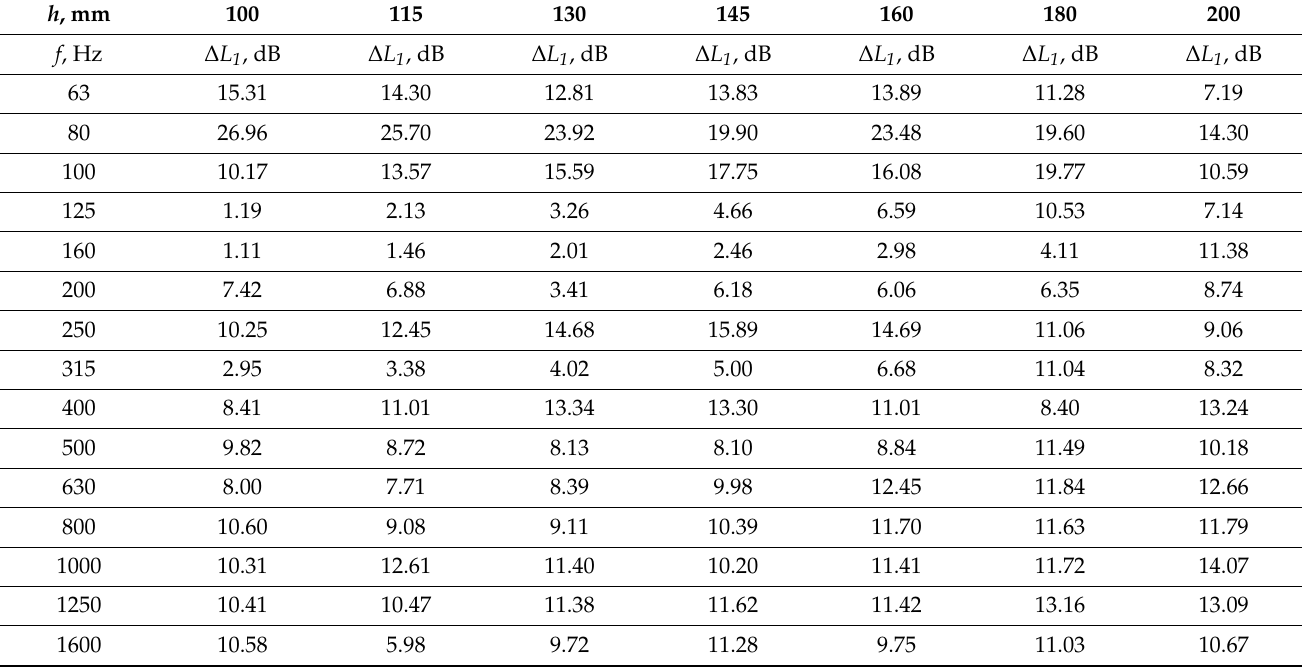
Table 4. Results for calculations for ∆ L 1 at third-octaves for area 1 at a/b =